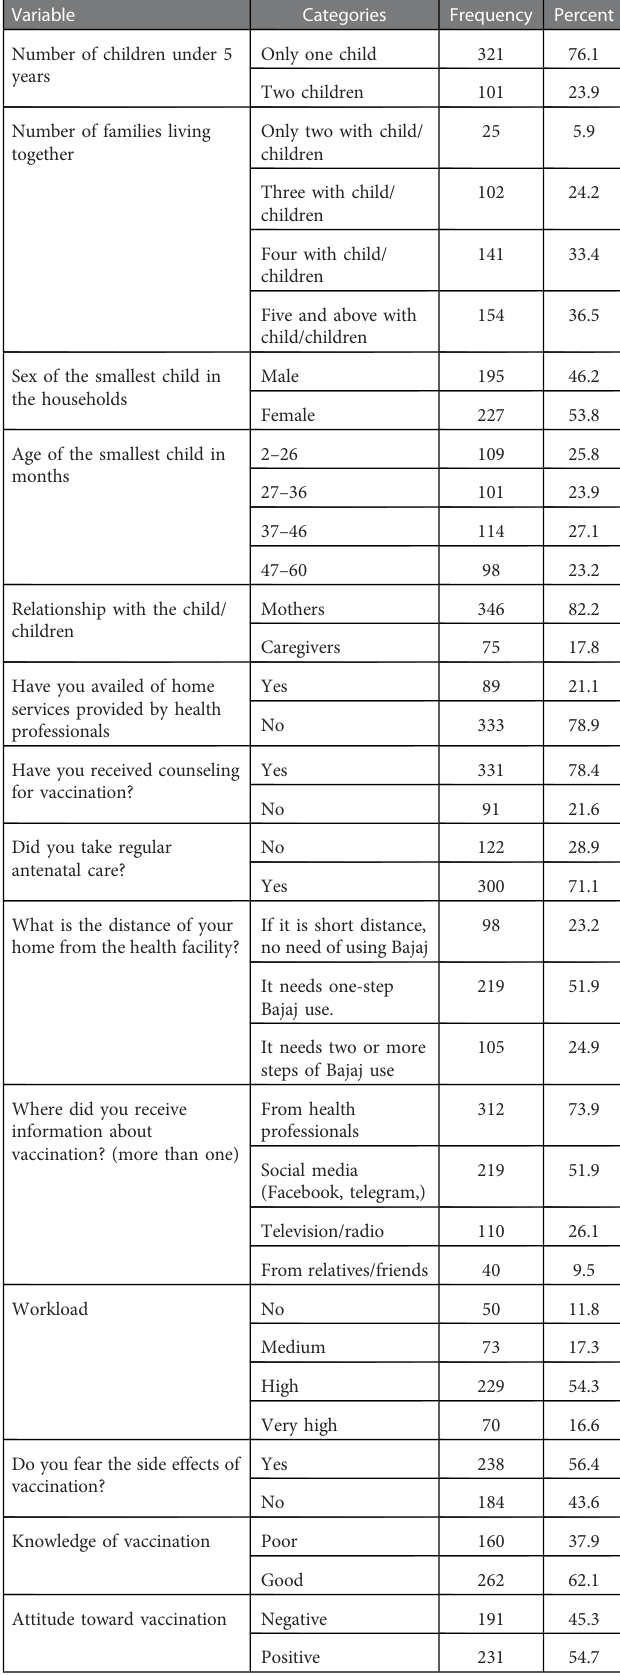
TABLE 1 Sociodemographic characteristics of study participants among mothers/caregivers in Debre Tabor, Northwest Ethiopia, 2022 ( n =422).